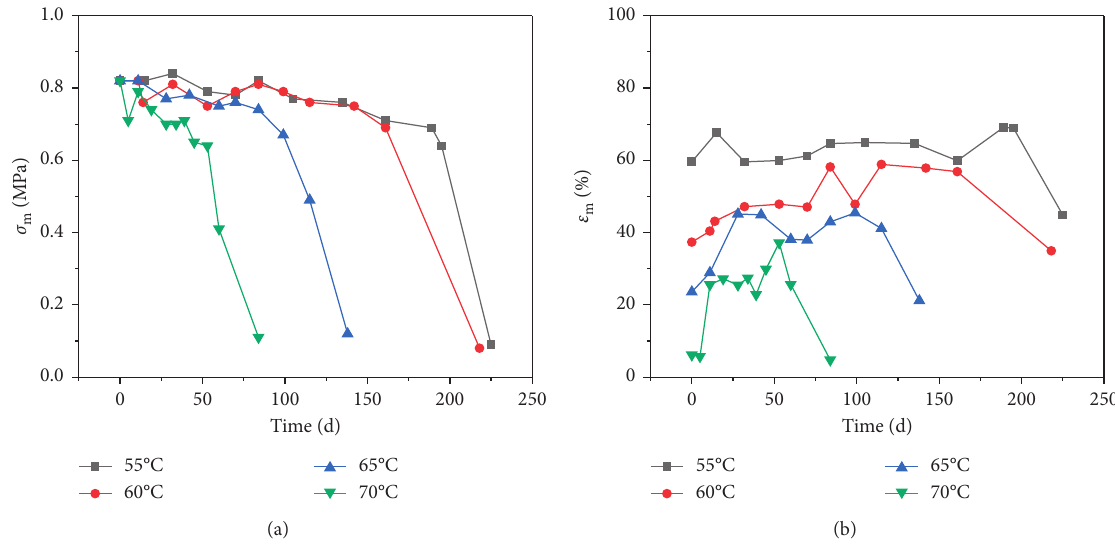
Figure 1: The change rule of σ m and ε m of NEPE at different storage temperatures.